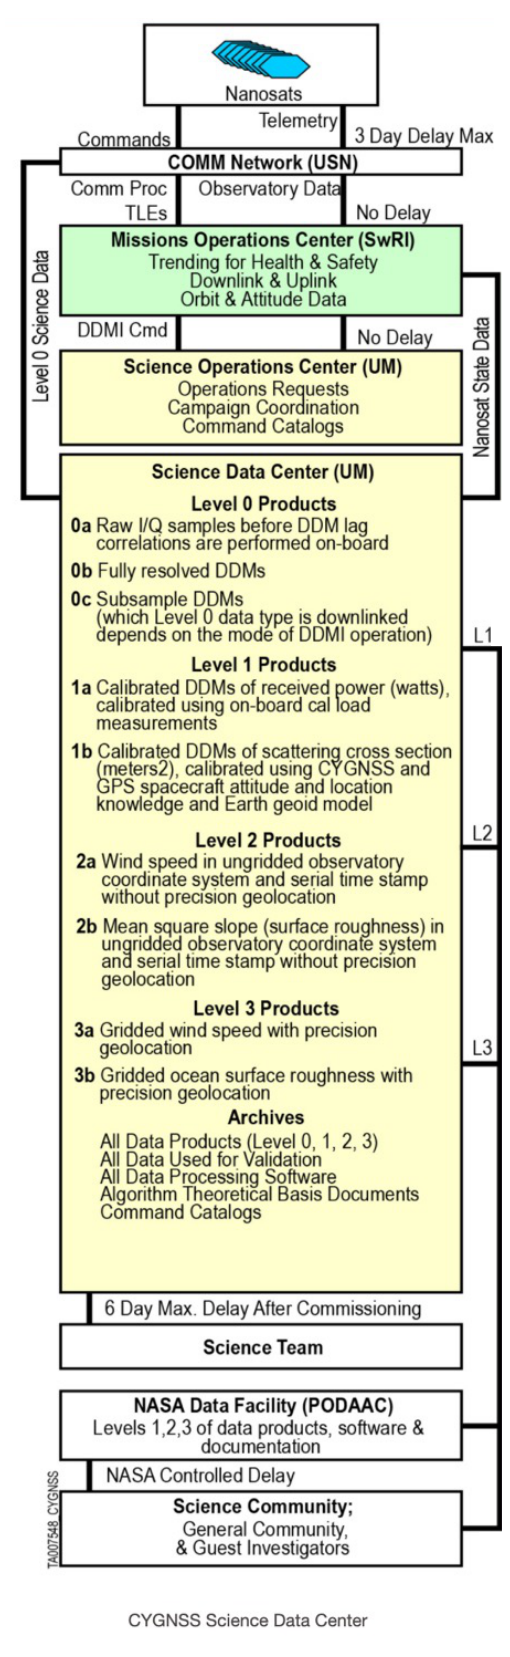
Figure 2. Data processing flow of the CYGNSS data products